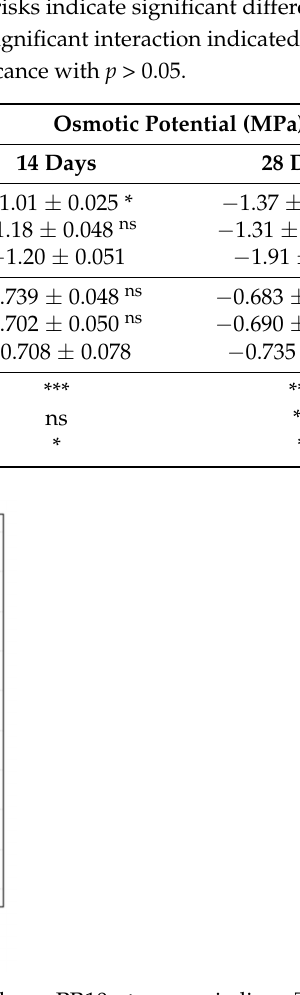
Figure 6. Chlorophyll index (SPAD) readings of faba bean PR10a transgenic lines TL-3 (green), TL-2 (red), and wild-type (blue) under non-stressed (circular symbols and solid lines) and salt stress conditions (triangle symbols and dashed lines) after 25 days of salt stress application. The measurement was carried out on leaves no. 3, 6, 12, 15, and 18 (from base to top), with three readings repeated for four sample plants. Data points represent the means ± SE. Asterisks indicate significant differences within treatment by Dunnett’s test using WT as control upon significant interaction indicated by two-way ANOVA. *** p < 0.001, ** p < 0.01, n, insignificance with p > 0.05. Under salinity, both PR10a and WT plants exhibited significantly lower leaf potas- sium (K + ), calcium (Ca 2+ ), and magnesium (Mg 2+ ) contents than in the controls with no significant differences between lines (Figures S3a, S4a, and S5a). Similarly, stem and root K + contents tended to be lower under salt stress (Figure S3b,c), while root Ca 2+ (Figure S4c) and stem Mg 2+ (Figure S5b) contents tended to increase, with insignificant differences between transgenic lines and